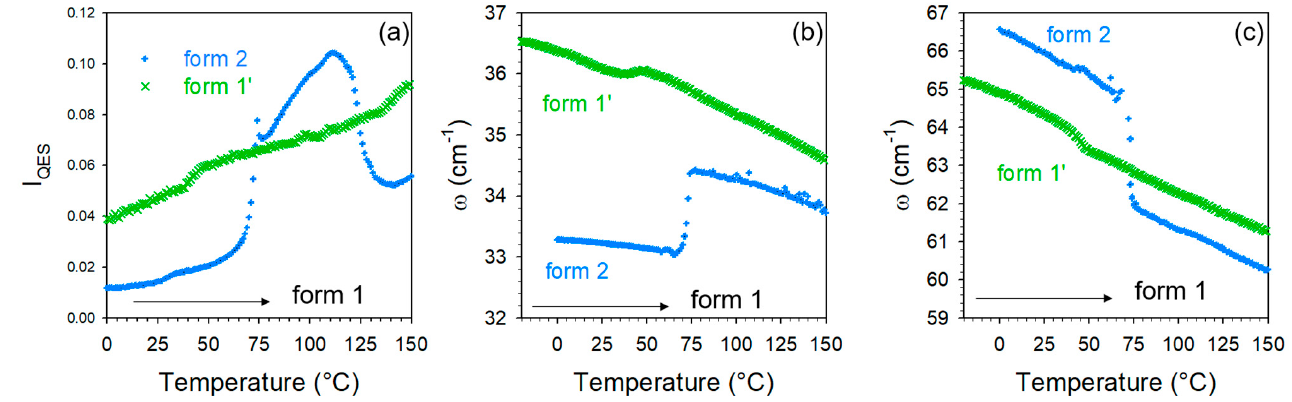
Figure 6. Data analysis of the low-frequency spectra of the co-crystal form 1 ′ and 2; ( a ) temperature dependence of the quasielastic intensity (I QES ); ( b ) temperature dependence of the position of the phonon peak located around 35 cm − 1 ; ( c ) temperature dependence of the position of the Raman band located around 66 cm − 1 .